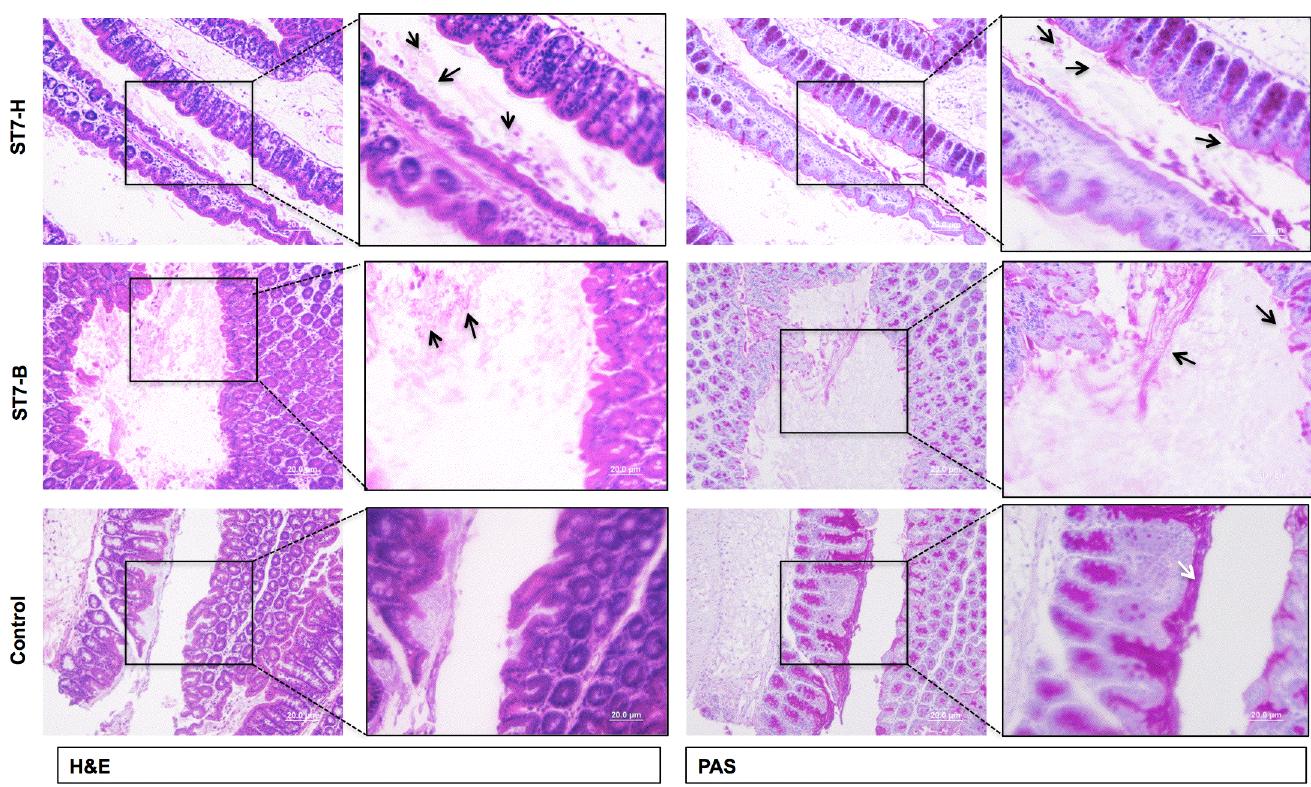
Fig 4. Blastocystis spp. remains luminal and binds to mucin in vivo . Representative histology of colon loops from DSS treated C57BL/6 mice (starved overnight to minimize intestinal contents) inoculated with 5x10 7 Blastocystis spp. ST7-H or ST7-B or saline (controls) for 1 hour in vivo , gently washed and preserved in methacarn. Blastocystis spp . were found only in the lumen and mucus layer for both isolates. Black arrows indicate luminal and mucin bound parasites and the white arrow in the control tissue shows well-preserved PAS stained inner mucin layer.